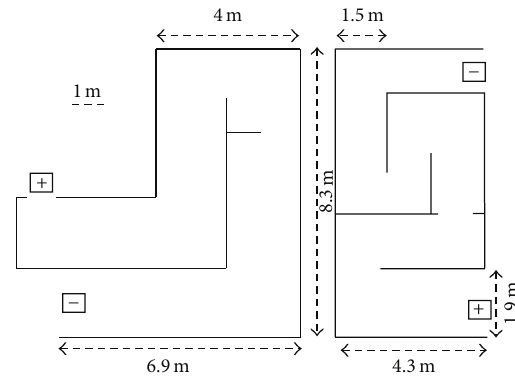
Figure 4: Paths used in the experiment. Path A (left) was 22m long and path B (right) was 19.6 m long. Squares indicate either the start or finish, depending on the route